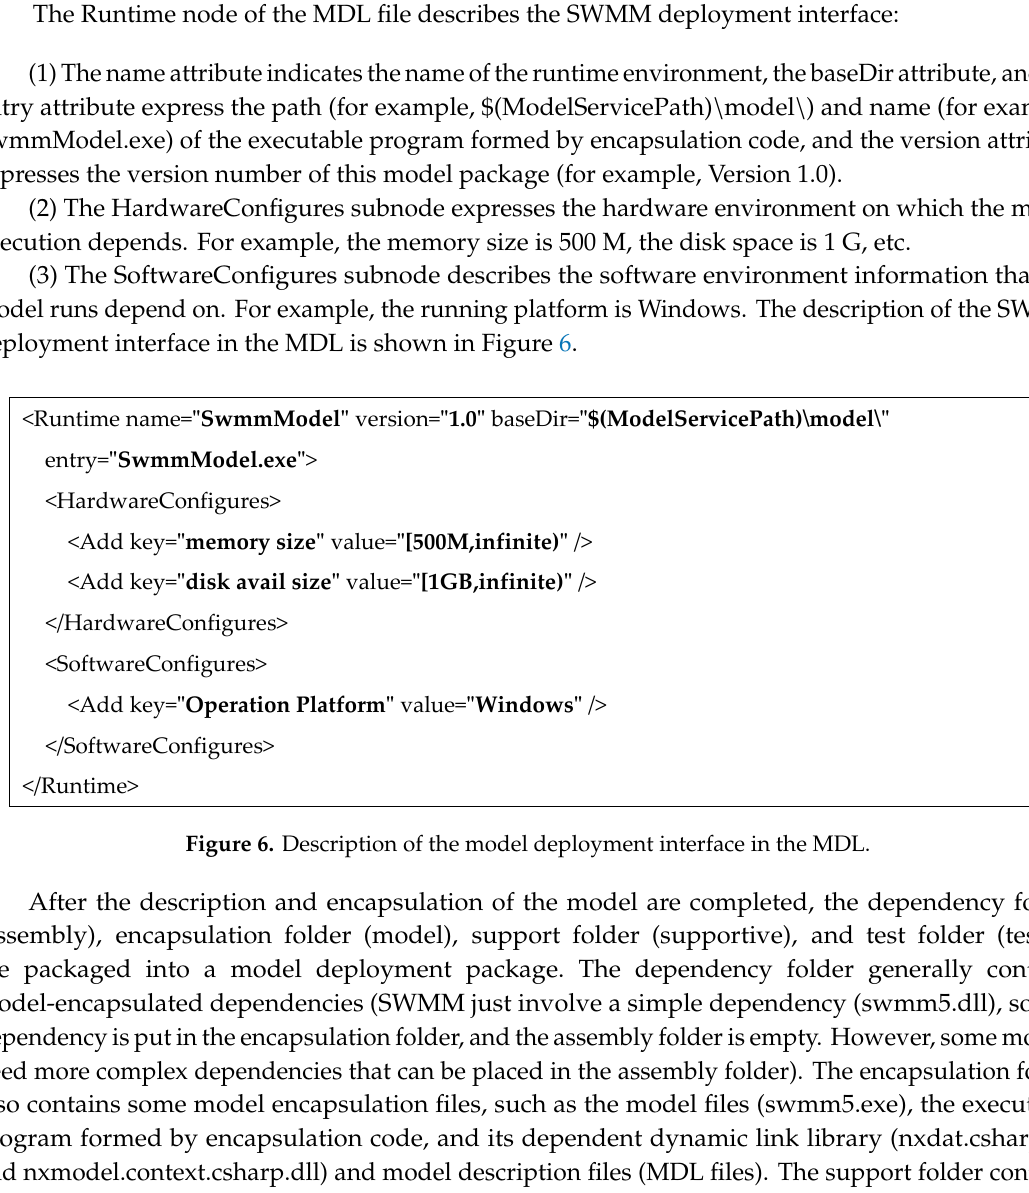
Figure 5. Encapsulation code for the SWMM execution interface.